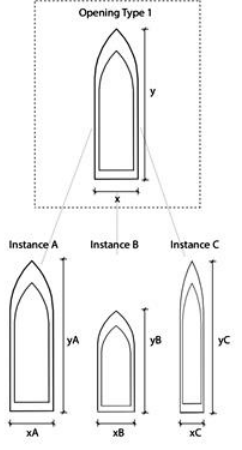
Figure 5. Diagram expressing the capacity for multiple instances of varying scale to be derived from a single typical opening type. By updating the opening type all of its instances are also automatically